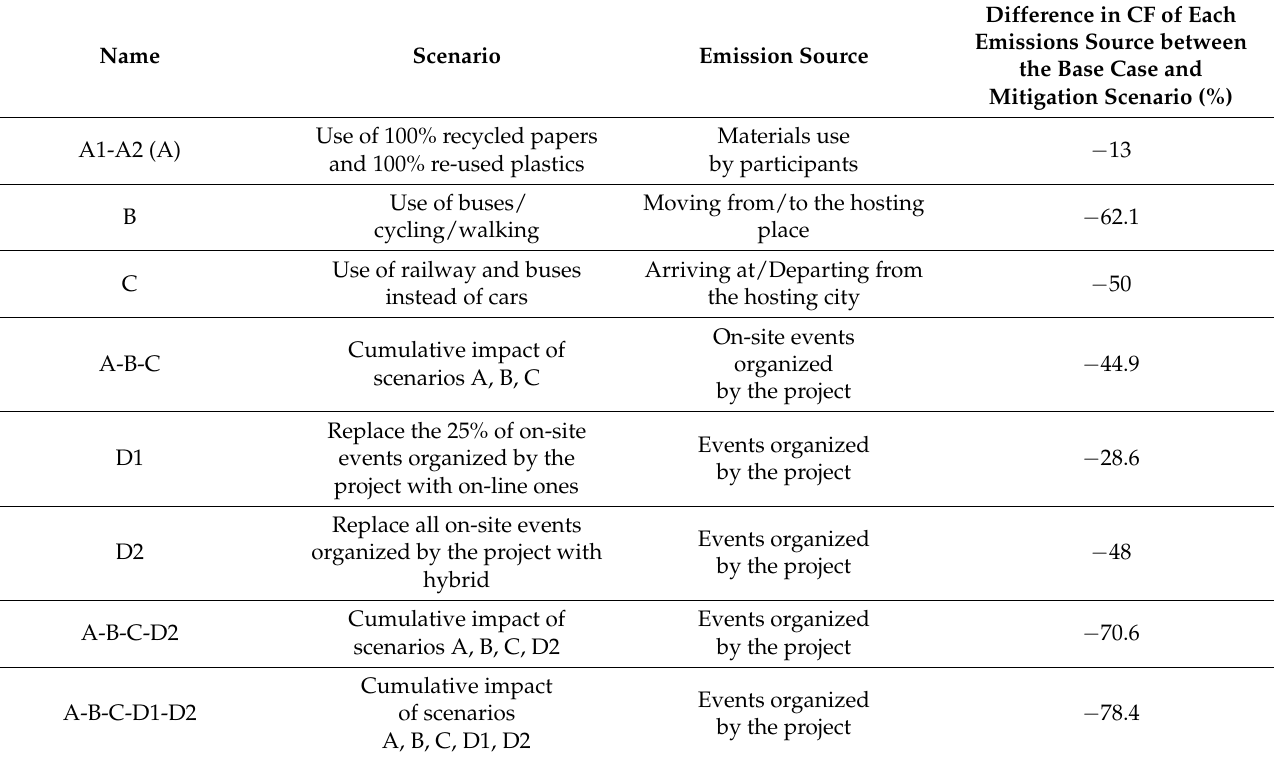
Table 7. Percentage differences (%) in CF between the base case and the individual mitigation scenarios related to events organized by the